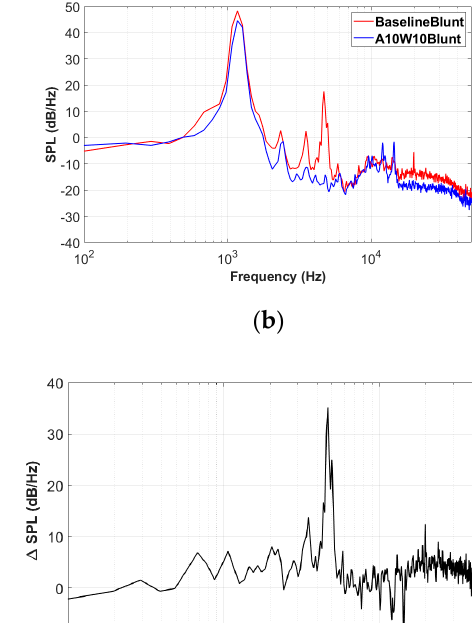
Figure 7. The distribution of 72 receiver points.